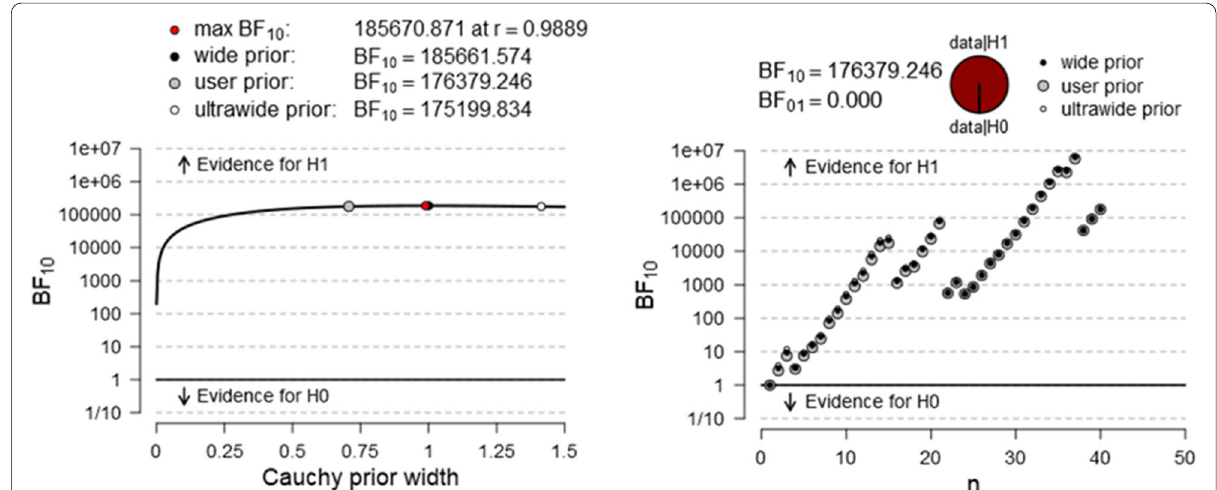
Fig. 3 Bayes factor robustness check for differences between RCT time on screen and paper format